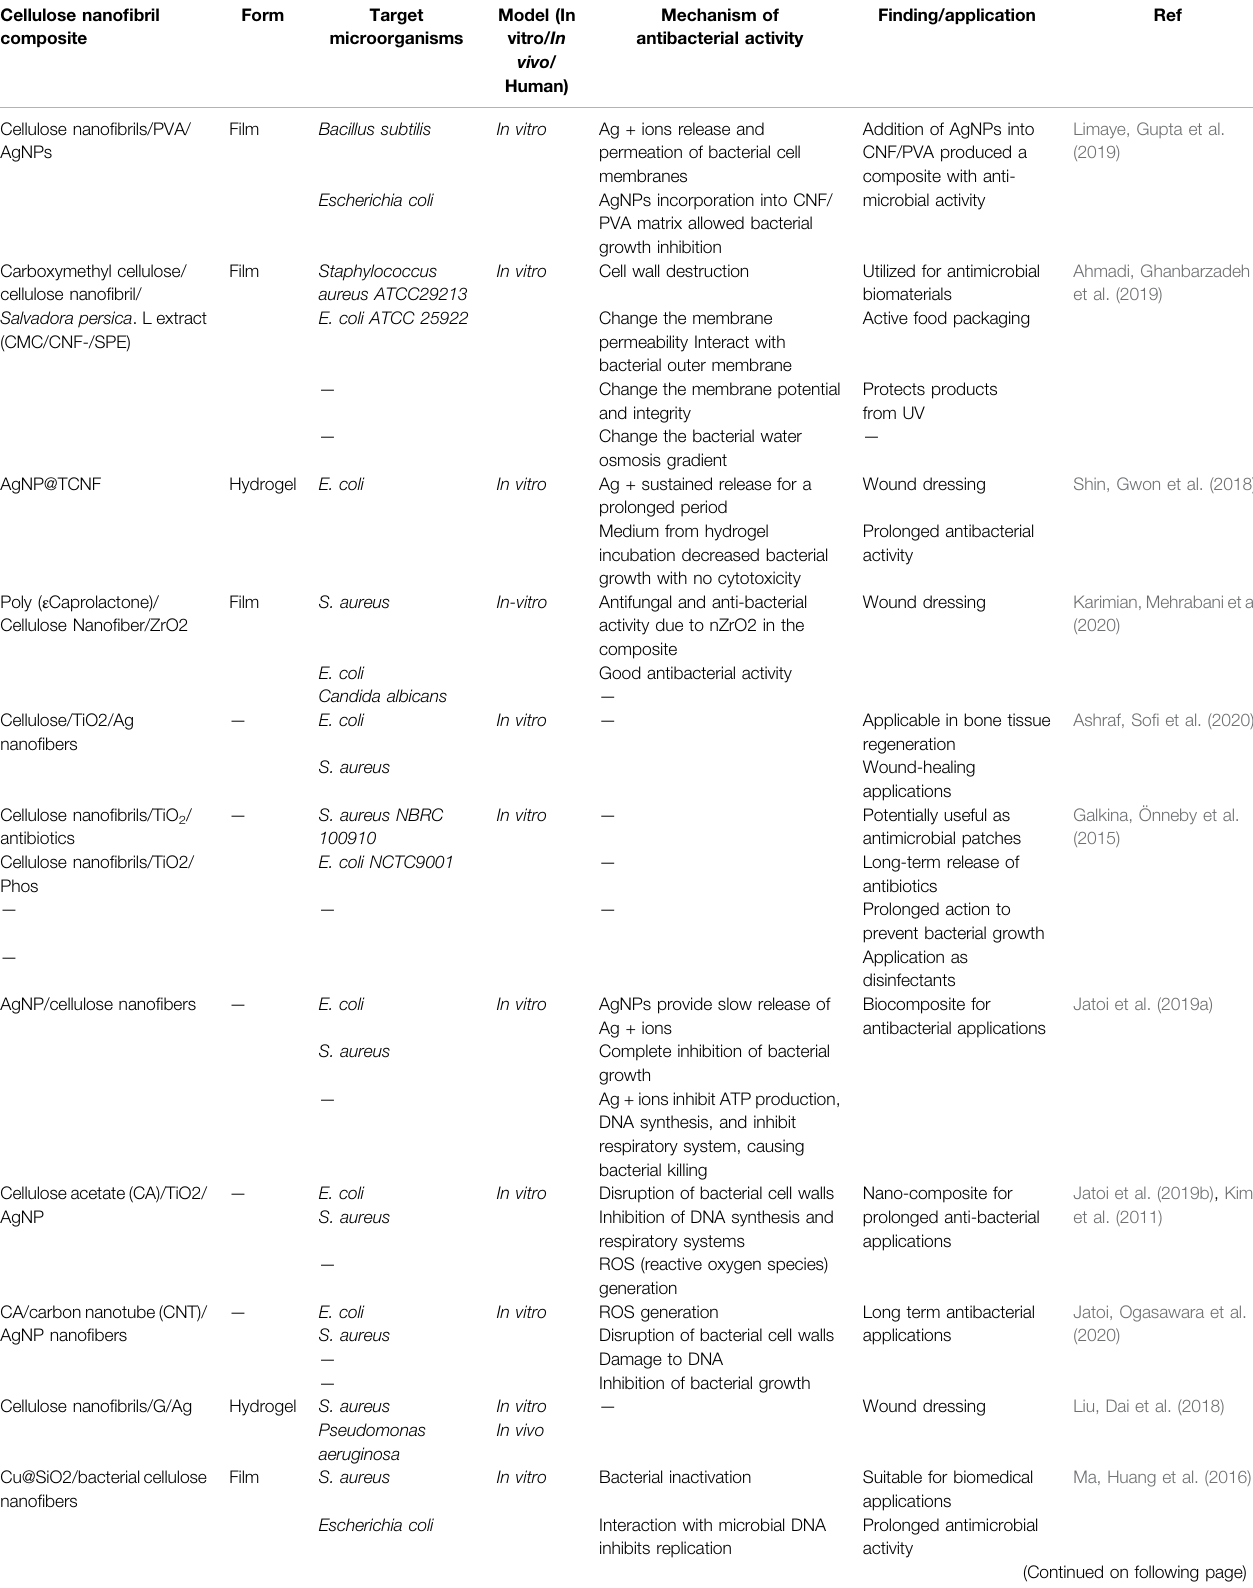
TABLE 1 | Various cellulose-based nano fi brils used against bacterial